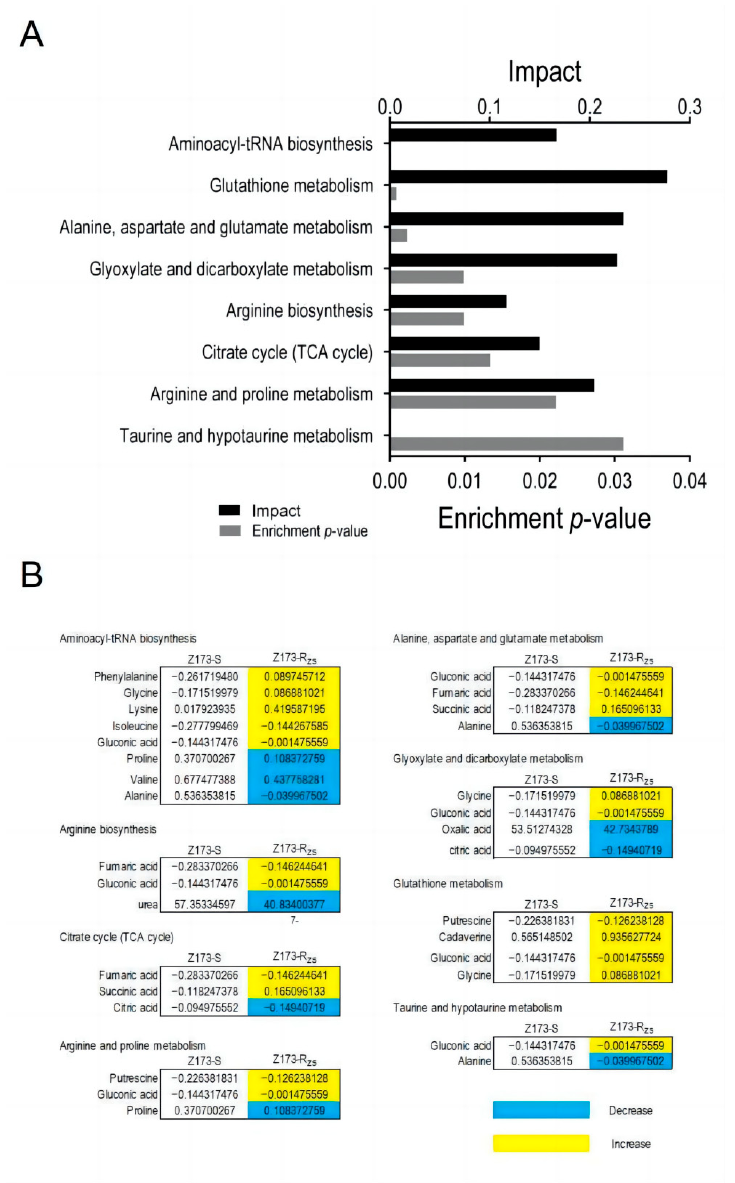
Figure 3. Pathways enrichment. ( A ) Pathways are enriched in differential abundance of metabolites between Z173-S and Z173-R ZS . ( B ) Integrative analysis of metabolites of Z173-R ZS compared with Z173-S in significantly enriched pathways. Numbers show the relative values of differential metabolites. Shades of yellow and blue indicate increases and decreases in metabolites, respectively.